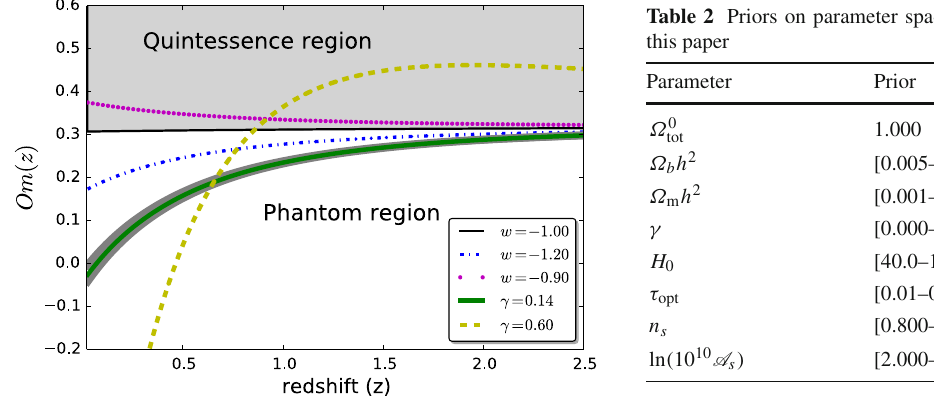
Fig. 10 Om ( z ) diagnostic: solid lines represents Om ( z ) for the cos- mological constant. Dashed and dot-dashed lines represents Om ( z ) for Λ CDM with w = − 0 . 90 and w = − 1 . 20, respectively. Thick solid line with corresponding 1 σ confidence interval determined by JLA observation represents Om ( z ) for the viscous dark energy model for γ = 0 . 14. A long-dashed line corresponds to γ = 0 . 60 demonstrating that dynamical dark energy model has almost quintessence behavior during the evolution of the Universe